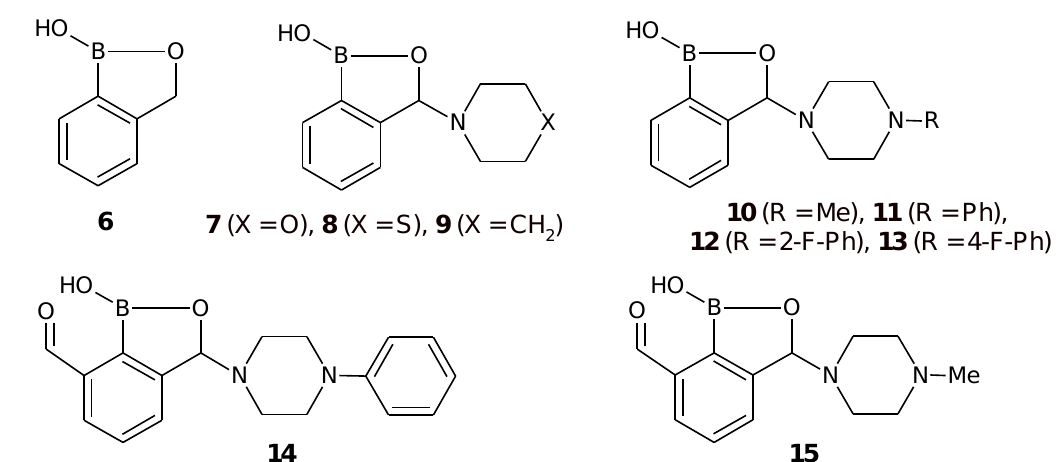
Figure 3. Structures of unsubstituted benzoxaborole ( 6 ) and its studied derivatives ( 7–15 ).